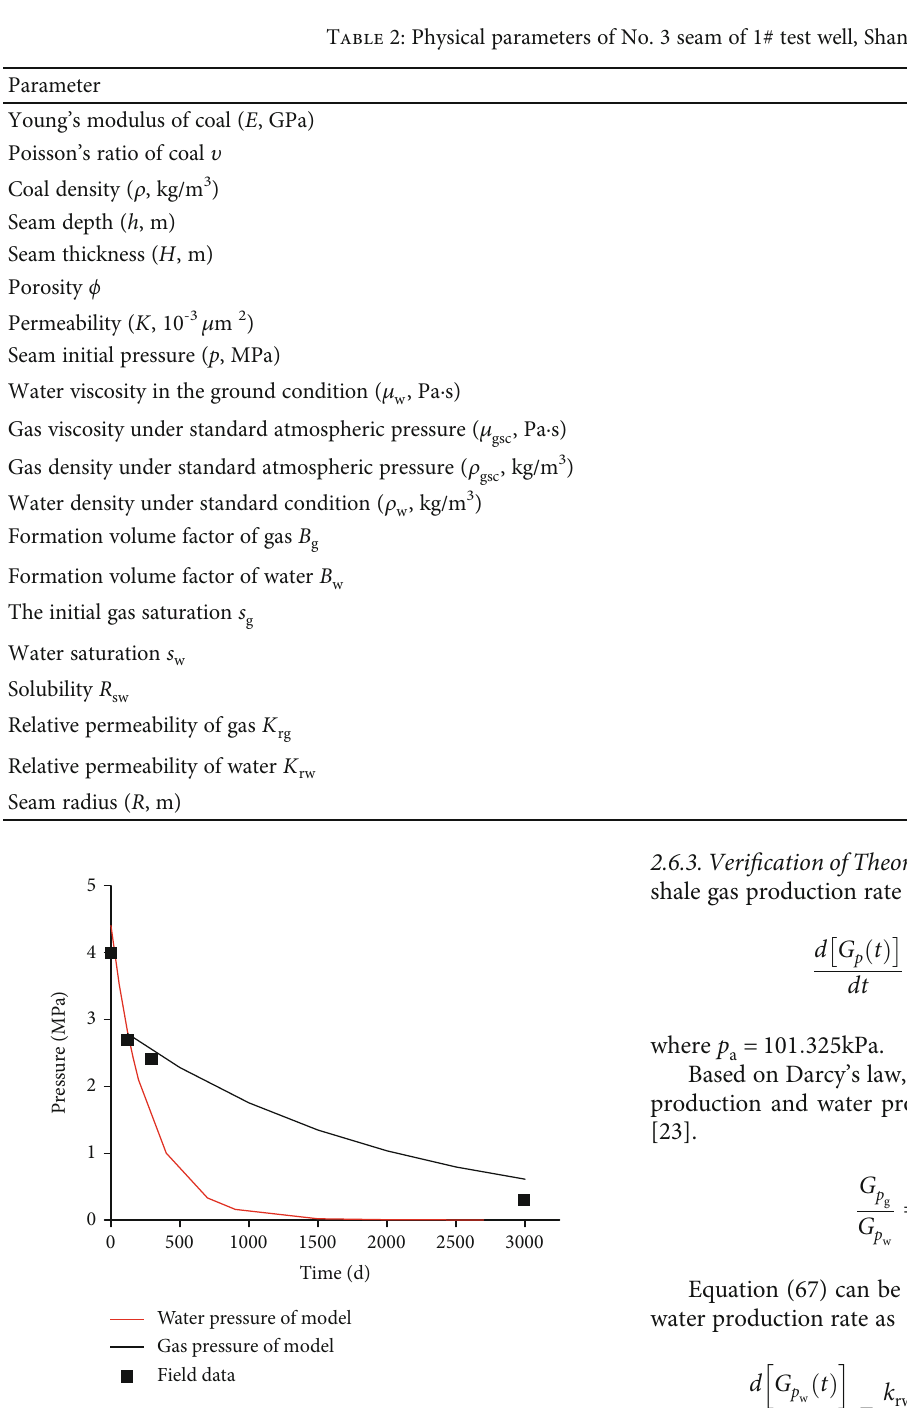
Figure 2: Variation of fl uid pressure with